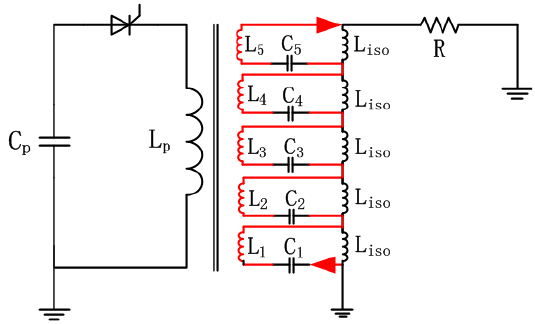
Figure 11. The circuit of the trigger source.